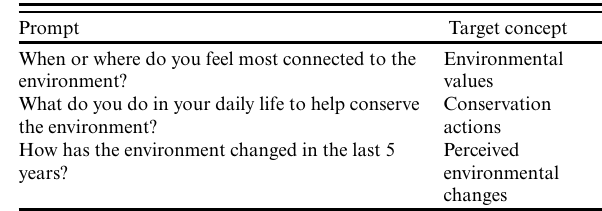
Table 2. Prompts given to participants for photovoice